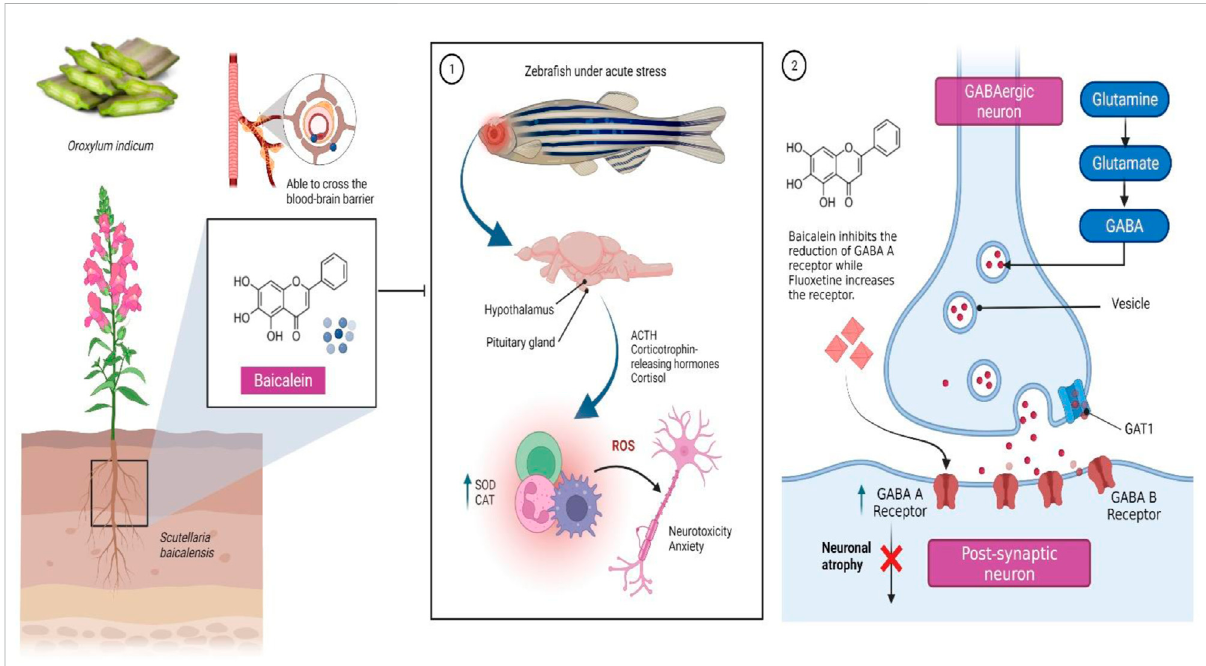
FIGURE 1 Baicalein, a bioactive molecule found in Scutellaria baicalensis Georgi and Oroxylum indicum (L.) Kurz, has been shown to be effective in the treatment of neuropsychiatric diseases, particularly anxiety occuring as a result of 1) dysregulation of hormones released from the hypothalamic- pituitary-adrenal (HPA) axis, which when aggravated by a stressor result in chronic oxidative stress and neurotoxicity. It has been suggested that the selective serotonin reuptake inhibitor (SSRI) fl uoxetine, which helps to upregulate GABA receptors, may work through a similar mechanism to baicaleintopreventseizures.2)Baicaleinreversesthedeclineintheexpressionofthereceptorshencemaypreventneuronalatrophy.Abbreviations: ACTH, Adrenocorticotropin; SOD, Superoxide dismutase; CAT, Catalase; ROS, Reactive oxygen species; GAT1, GABA transporter